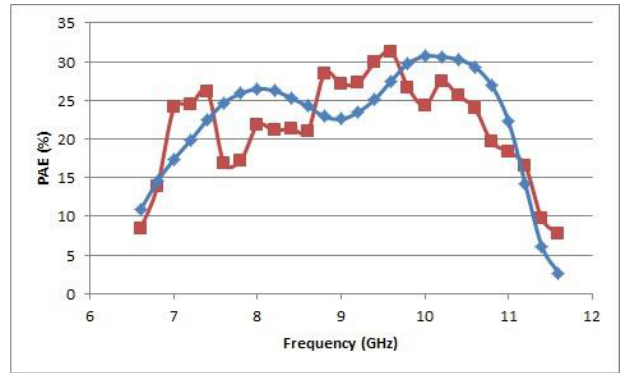
Figure 13: Power added efficiency for amplifier operating between 8-10 GHz. Blue line: simulation, red line: measurement